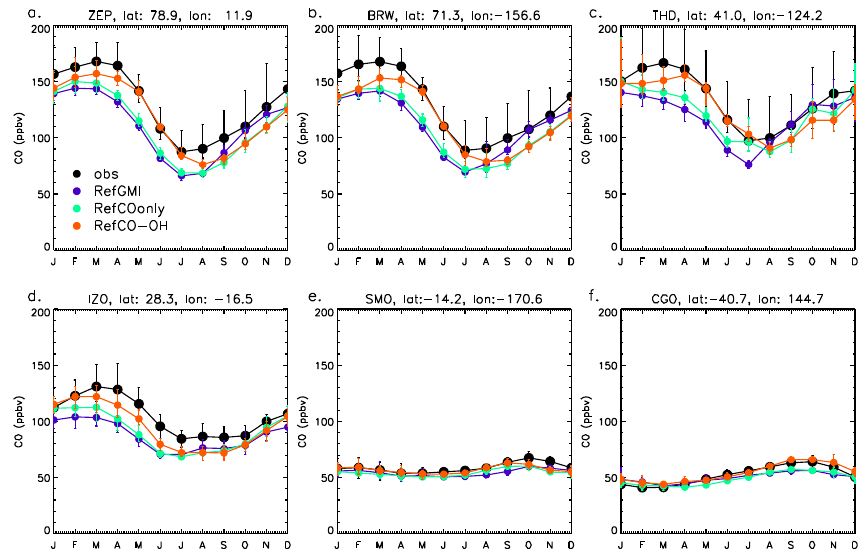
Figure 2. Monthly mean GMD observations (black) and results from the RefGMI (purple), RefCOonly (green), and RefCO–OH (orange) simulations. Circles and error bars represent the mean and min–max range, respectively, for 1999–2009. The GMD sites are as follows: (a) Ny-Alesund, Svalbard (ZEP, 78.9 ◦ N, 11.9 ◦ E); (b) Barrow, Alaska (BRW, 71.3 ◦ N, 156.6 ◦ W); (c) Trinidad Head, California (THD, 41.0 ◦ N, 124.2 ◦ W); (d) Izana, Tenerife, Canary Islands (IZO, 28.3 ◦ N, 16.5 ◦ W); Tutuila, American Samoa (SMO, 14.2 ◦ S, 170.6 ◦ W); and (e) Cape Grim, Tasmania (CGO, 40.7 ◦ S, 144.7 ◦